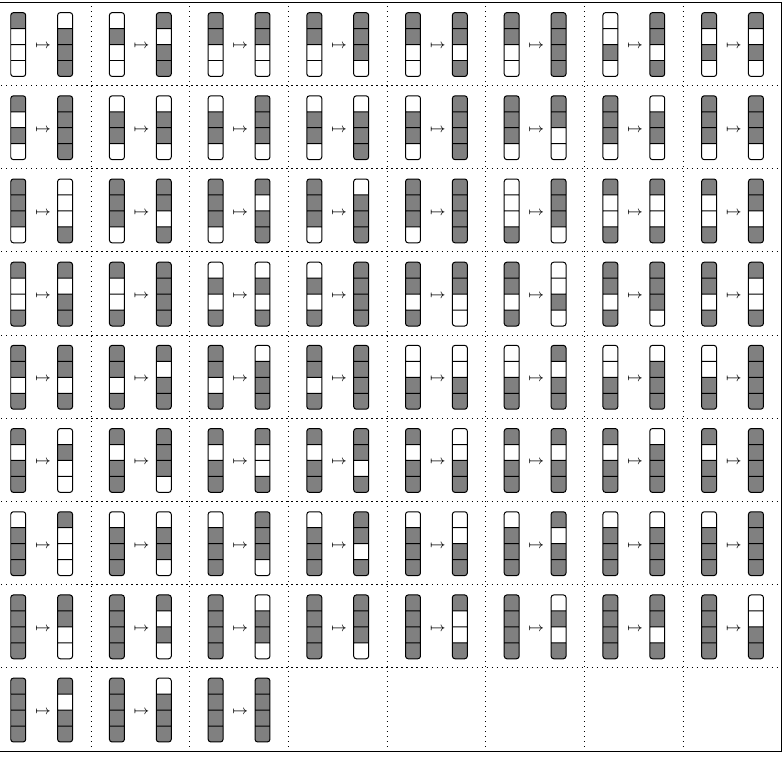
Figure 5: The Column-wise Active State Transitions for Class II